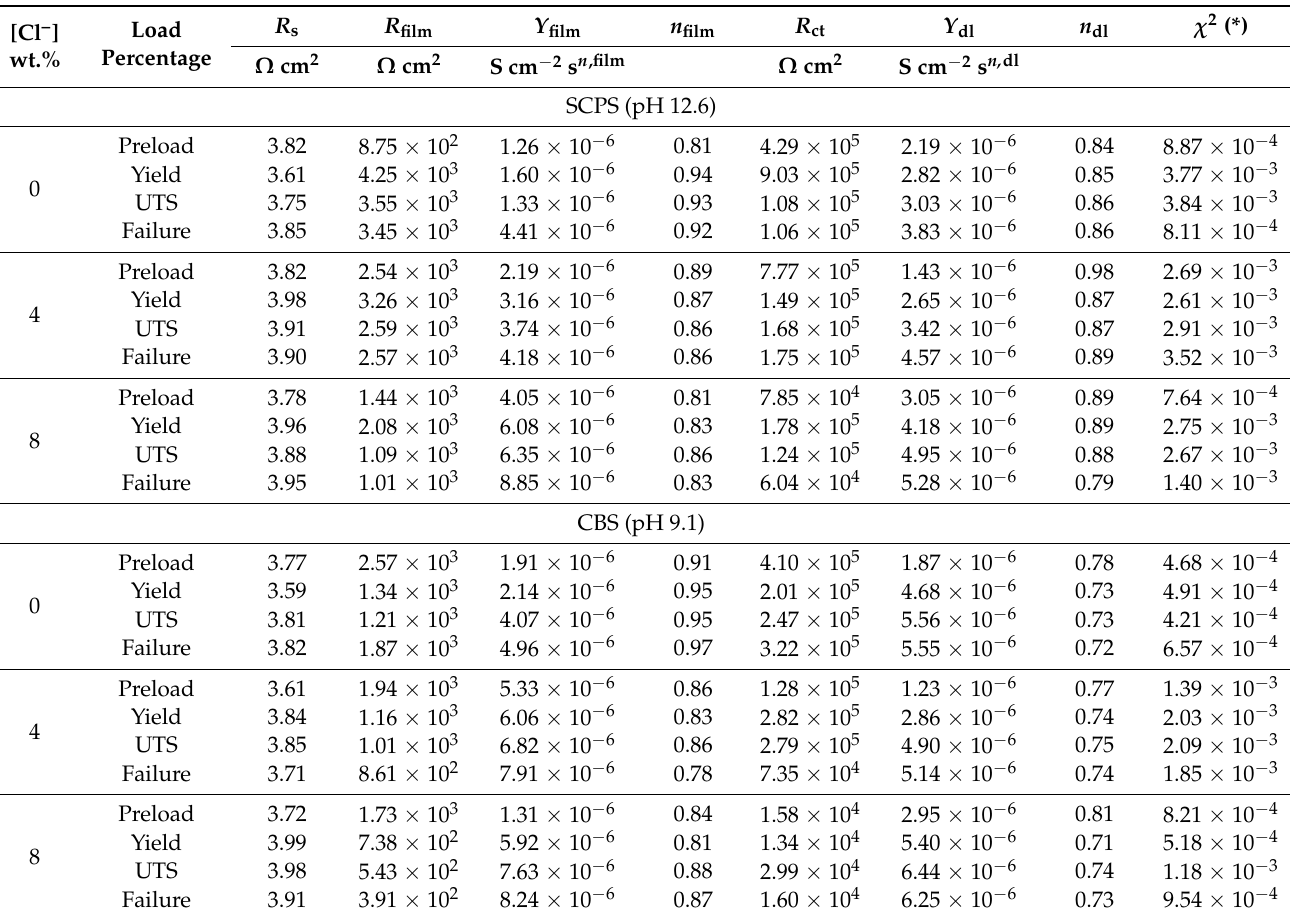
Figure 5. Electric equivalent circuit (EEC) with two time constants. Table 3. Fitting EIS parameters for UNS S32205 reinforcement during slow strain rate test (SSRT) for SCPS and CBS.